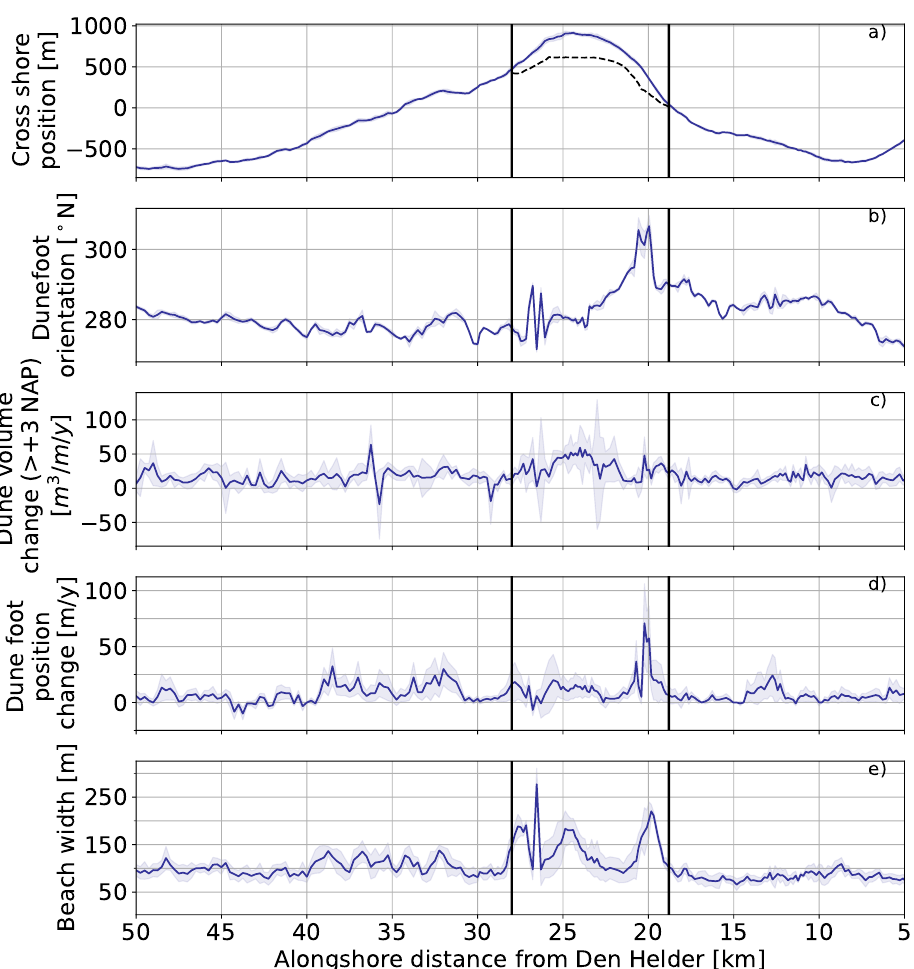
Figure 11. Dune evolution of North-Holland coast with the nourished section in between black lines (JARKUS dataset only). ( a ) Cross-shore position of the waterline (relative to the waterline position at km 0.2); the position of the prenourishment waterline is in black stripes. ( b ) Orientation of the dune foot. ( c ) Dune volume change, above 3 m + NAP. ( d ) Dune foot position change. ( e ) Beach